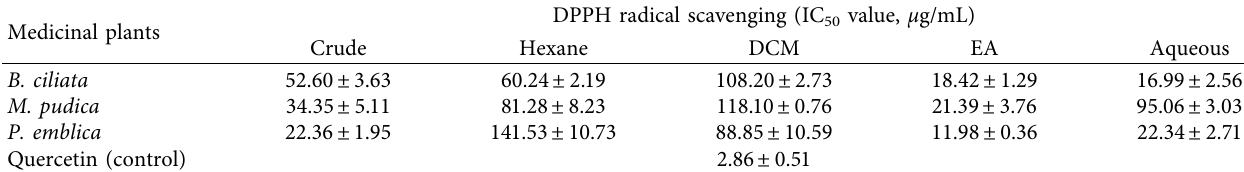
Table 4: Antioxidant activity of different fractions of selected